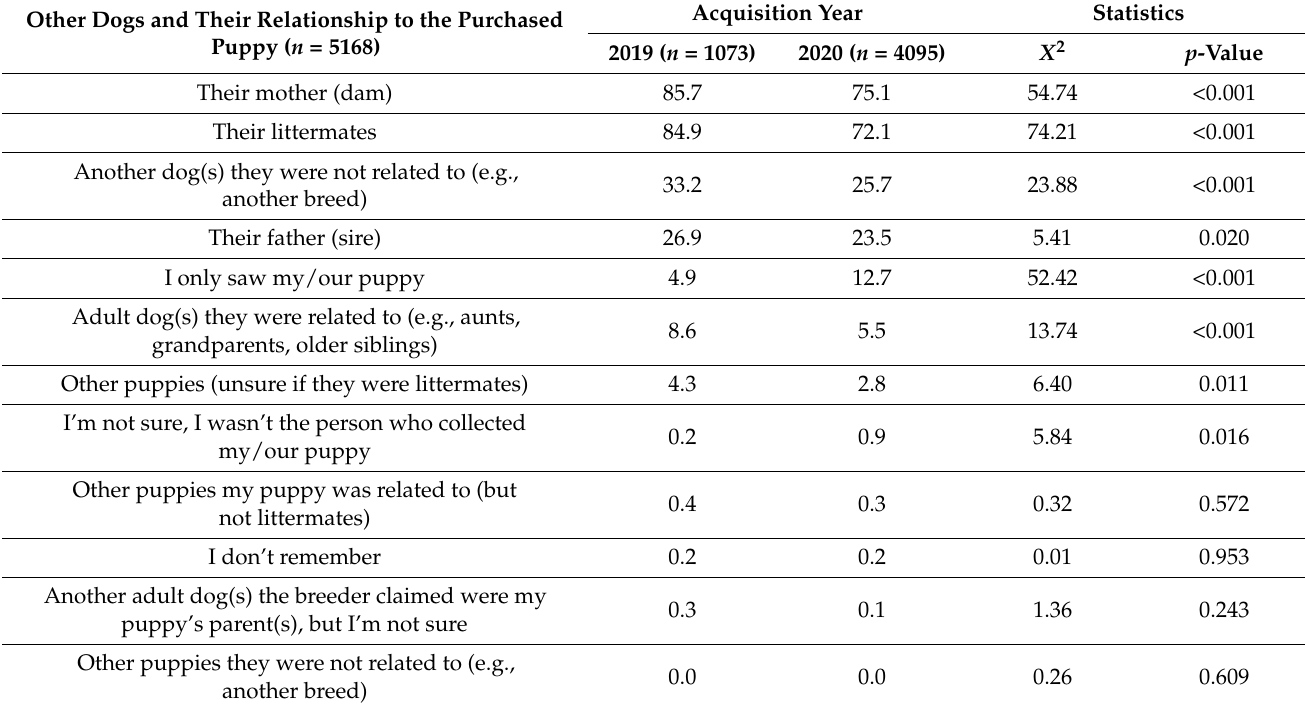
Table 13. Other dogs that were seen at the seller’s premises on the day of purchase of the puppy with comparison between 2019 puppy owners ( n = 1073) and Pandemic Puppy owners ( n = 4095) in the UK. Other Dogs and Their Relationship to the Purchased